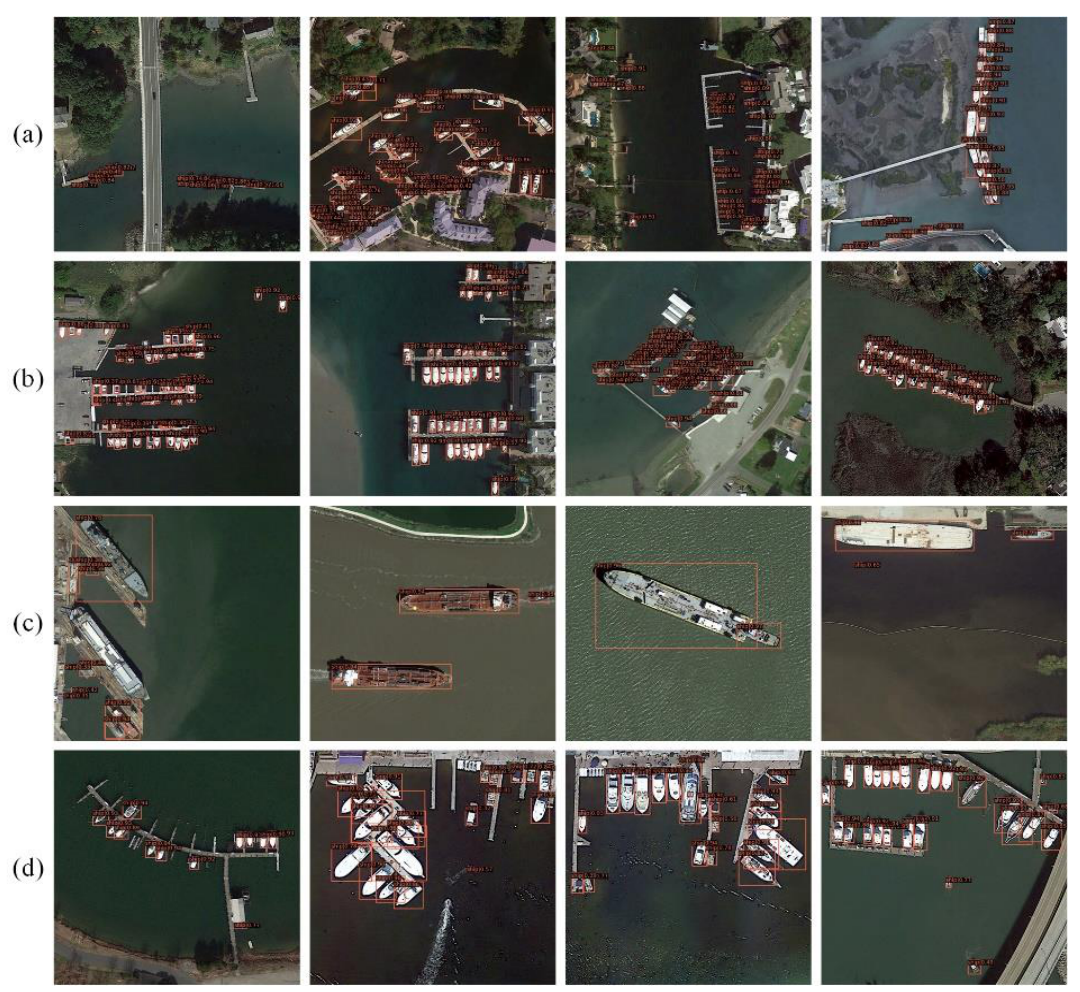
Figure 9. Some examples of the detection results on the DIOR dataset in different situations. ( a ) complex background; ( b ) dense distribution; ( c ) multiple scales; ( d ) different directions and aspect ratio. Table 4. Performance evaluation of different methods on the DIOR dataset.